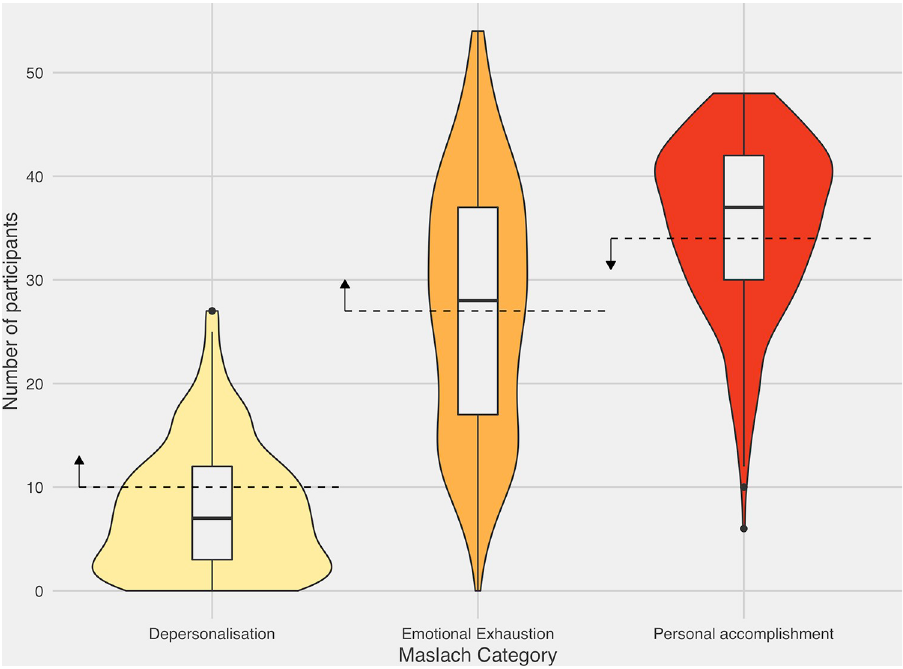
Fig 4. Violin plot showing the distribution of MBI scores for each of the three measures of depersonalisation, emotional exhaustion and personal accomplishment.